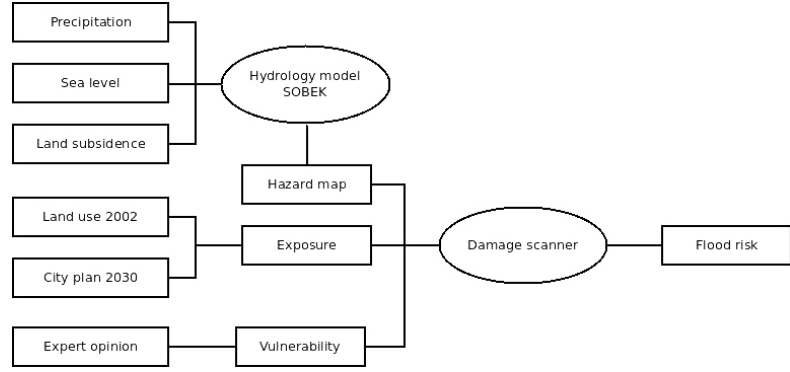
Figure 1. Framework of